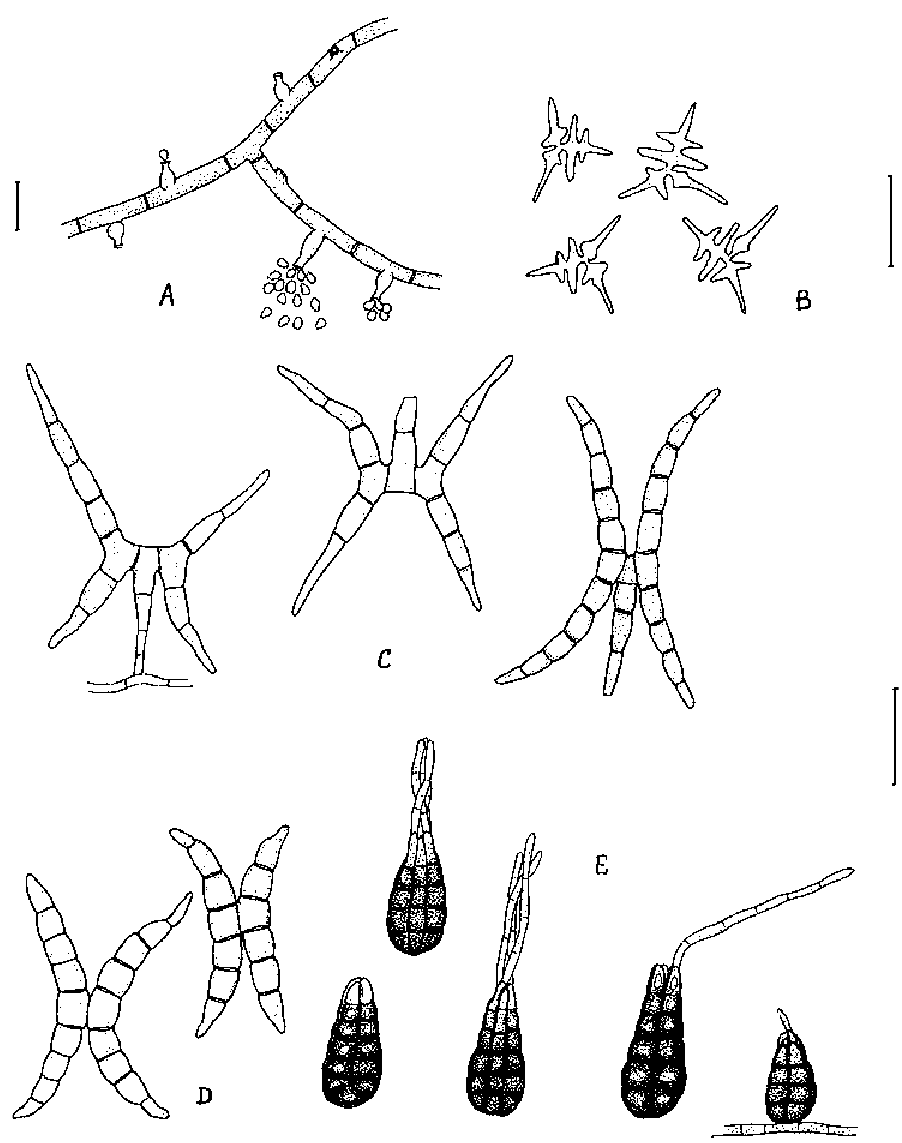
Fig. 1. A – hyphae with phialides and conidia of Cladorrhinum foecundissimum ; B – conidia of Lateriramulosa uni-inflata ; C – conidiophore with conidia of Dwayaangam cornuta ; D – conidia of Pyramidospora herculiformis ; E – conidia of Tetraploa setifera. Scale bars: A = 10 µm; B-E = 20